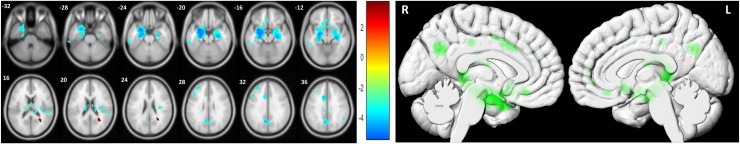
Results showing significant GM differences between the HC and mAD groups.